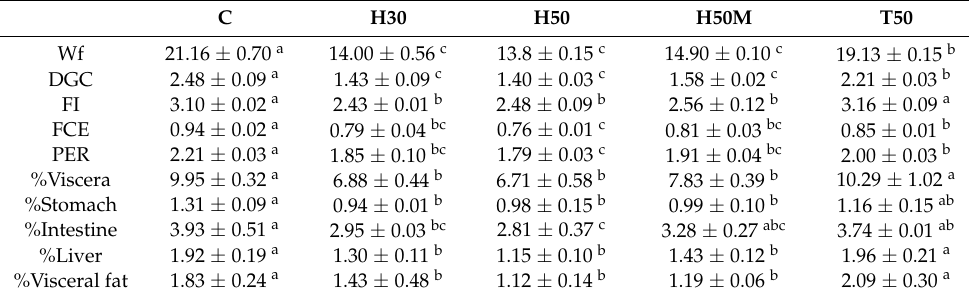
Table 4. Nutritional and growth indices and percentage of organs regarding final body weight of Sparus aurata fed with five experimental diets.